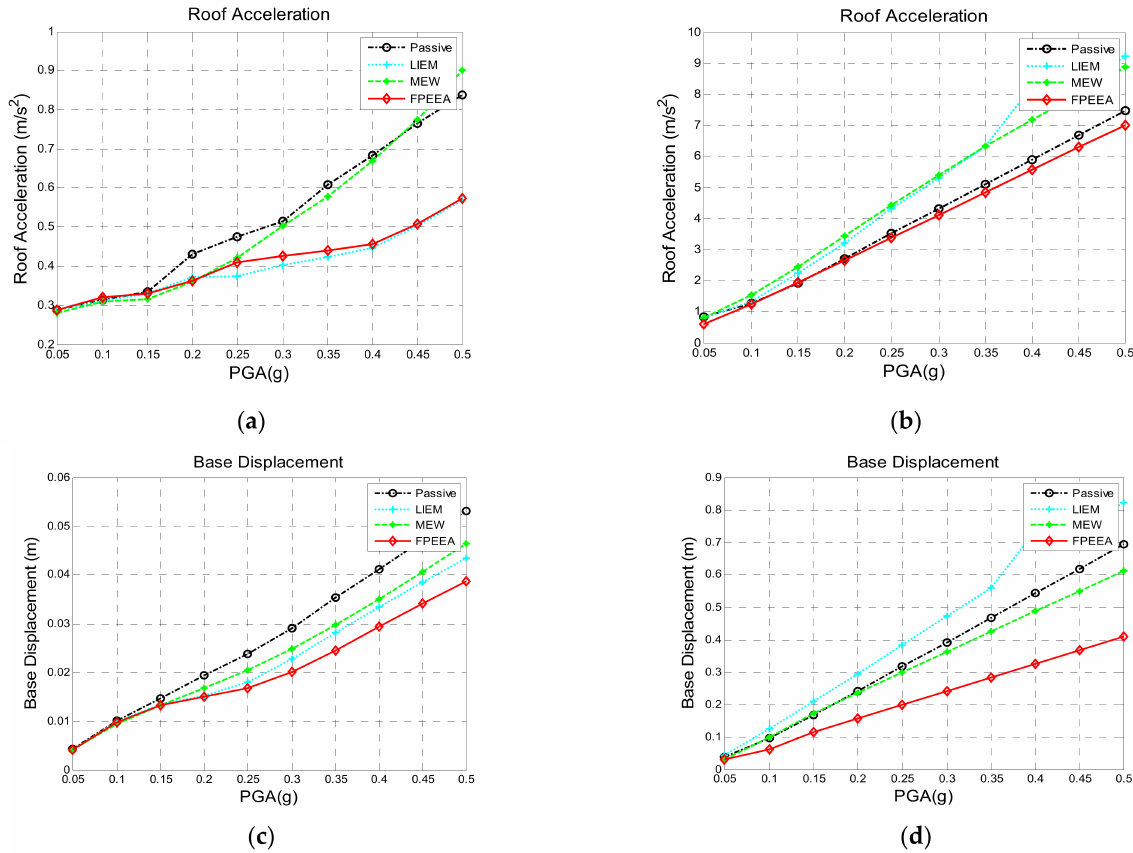
Figure 4. Comparison of the maximum responses of various control laws at different PGA values. ( a ) Superstructure acceleration (WhittierNarrows-01). ( b ) Superstructure acceleration (TCU068- EW). ( c ) Isolation layer displacement (Whittier Narrows-01). ( d ) Isolation layer displacement